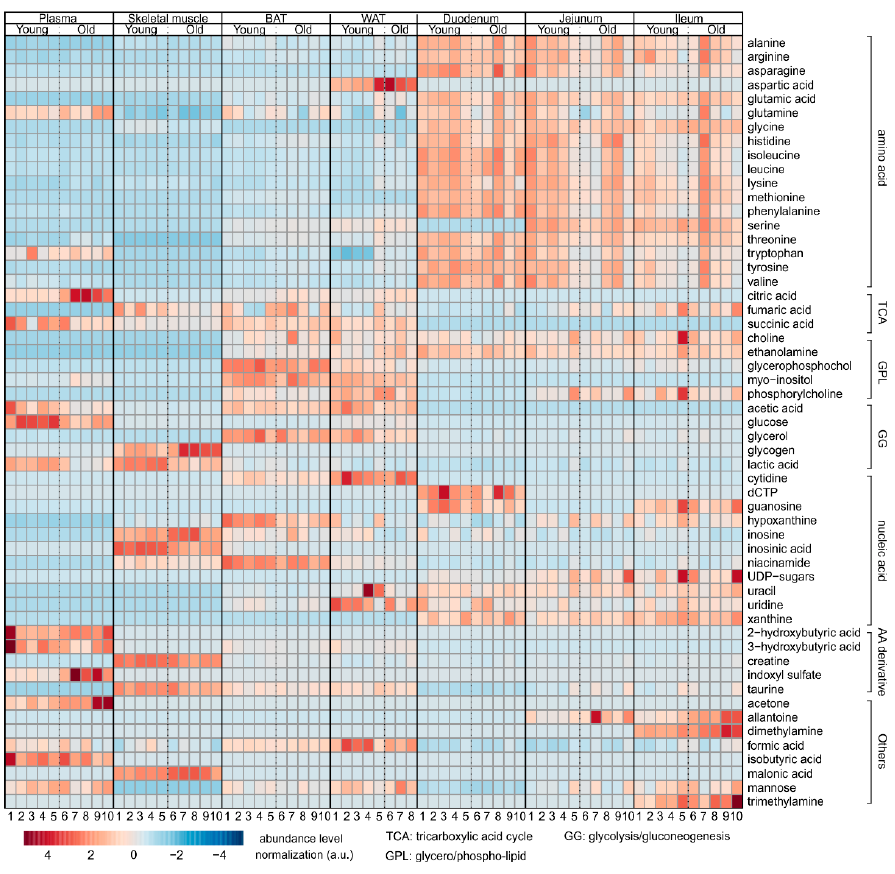
Figure 8. Heat map summarizing the results of NMR metabolomics analysis, indicating the alteration of metabolite levels from the respective tissues. Number of samples is indicated as 1–10 (1–8 for WAT) under each group, while the corresponding metabolites are indicated in each row. Increased metabolites are indicated in red, and decreased metabolites are indicated in blue.